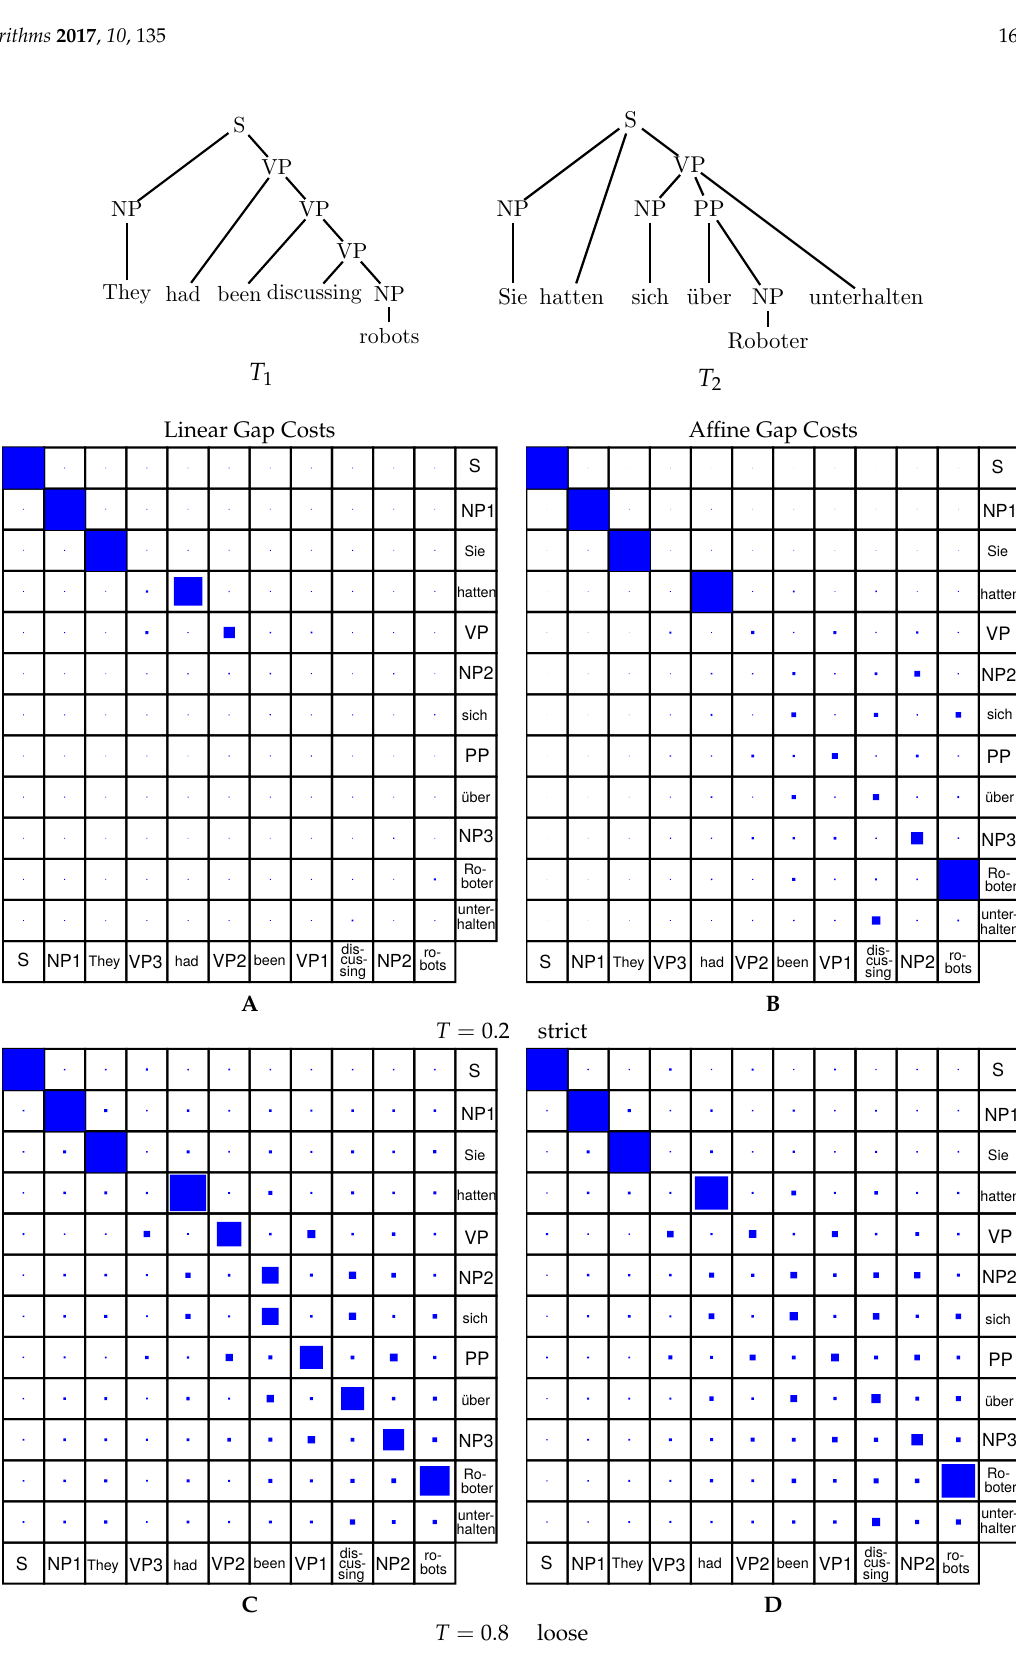
Figure 5. Match probabilities for alignments of the trees T 1 and T 2 for linear ( A , C ) and affine ( B , D ) gap costs, and for two different choices of the scaling parameter T , 0.2 ( A , B ) and 0.8 ( C , D ). The size of the squares scales logarithmically with the probability as 1/ ( 1 − log p ) . The score were set to − 2 for indels and mismatch, 2 for matches and − 1 for the affine gap costs in the affine case. The trees refer to syntax trees for a sentence in German ( T 2 ) and in English ( T 1 ) as shown